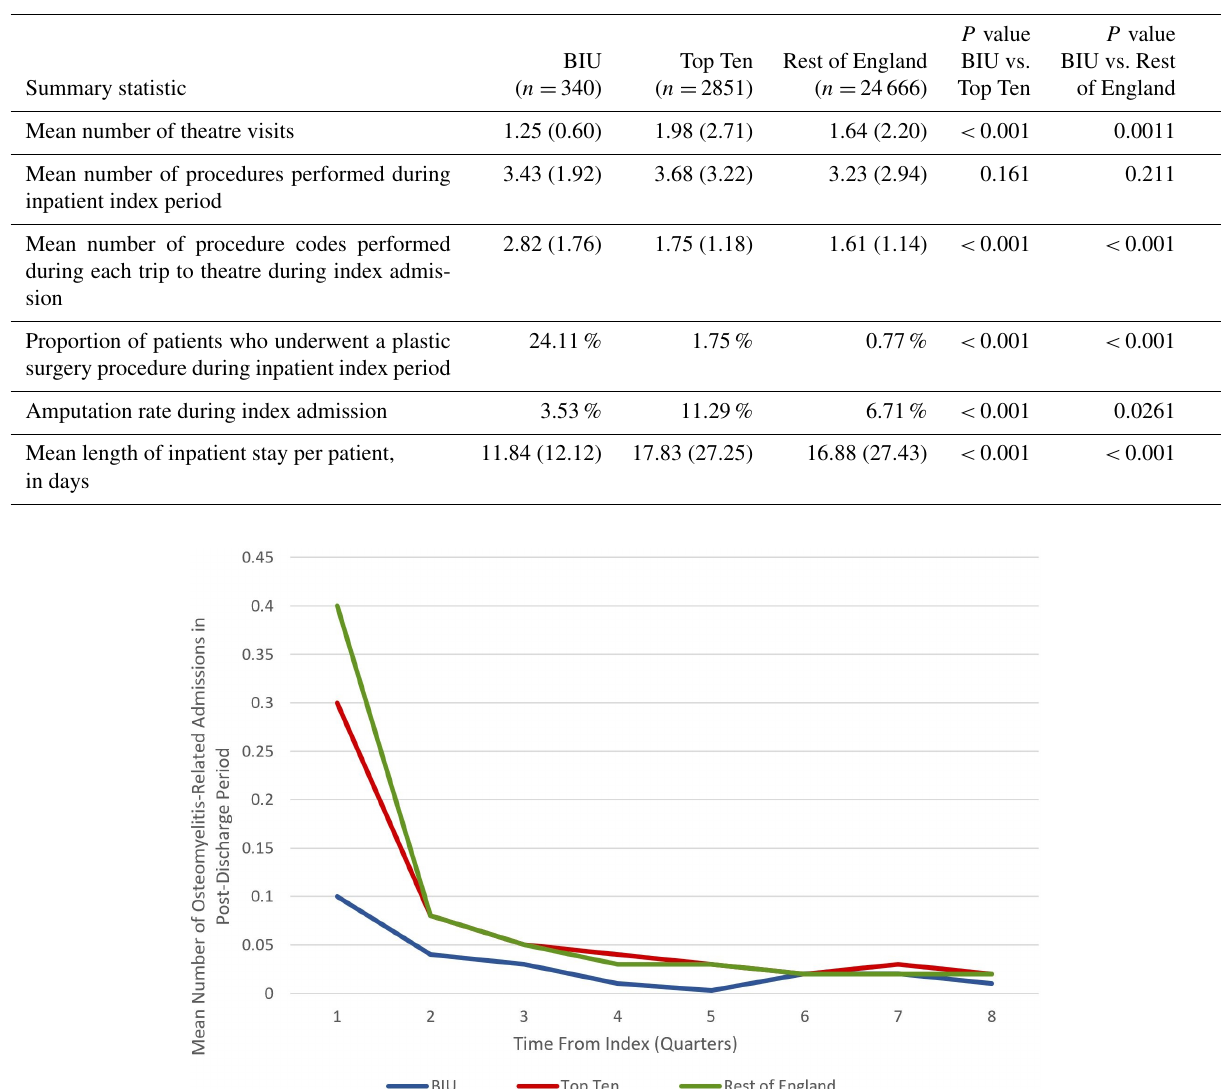
Table 2. Activity during the index admission hospital stay (defined as the whole inpatient spell) for first-ever surgery for osteomyelitis during the observation period across the three groups. Figures represent mean and (standard deviation) unless otherwise stated.